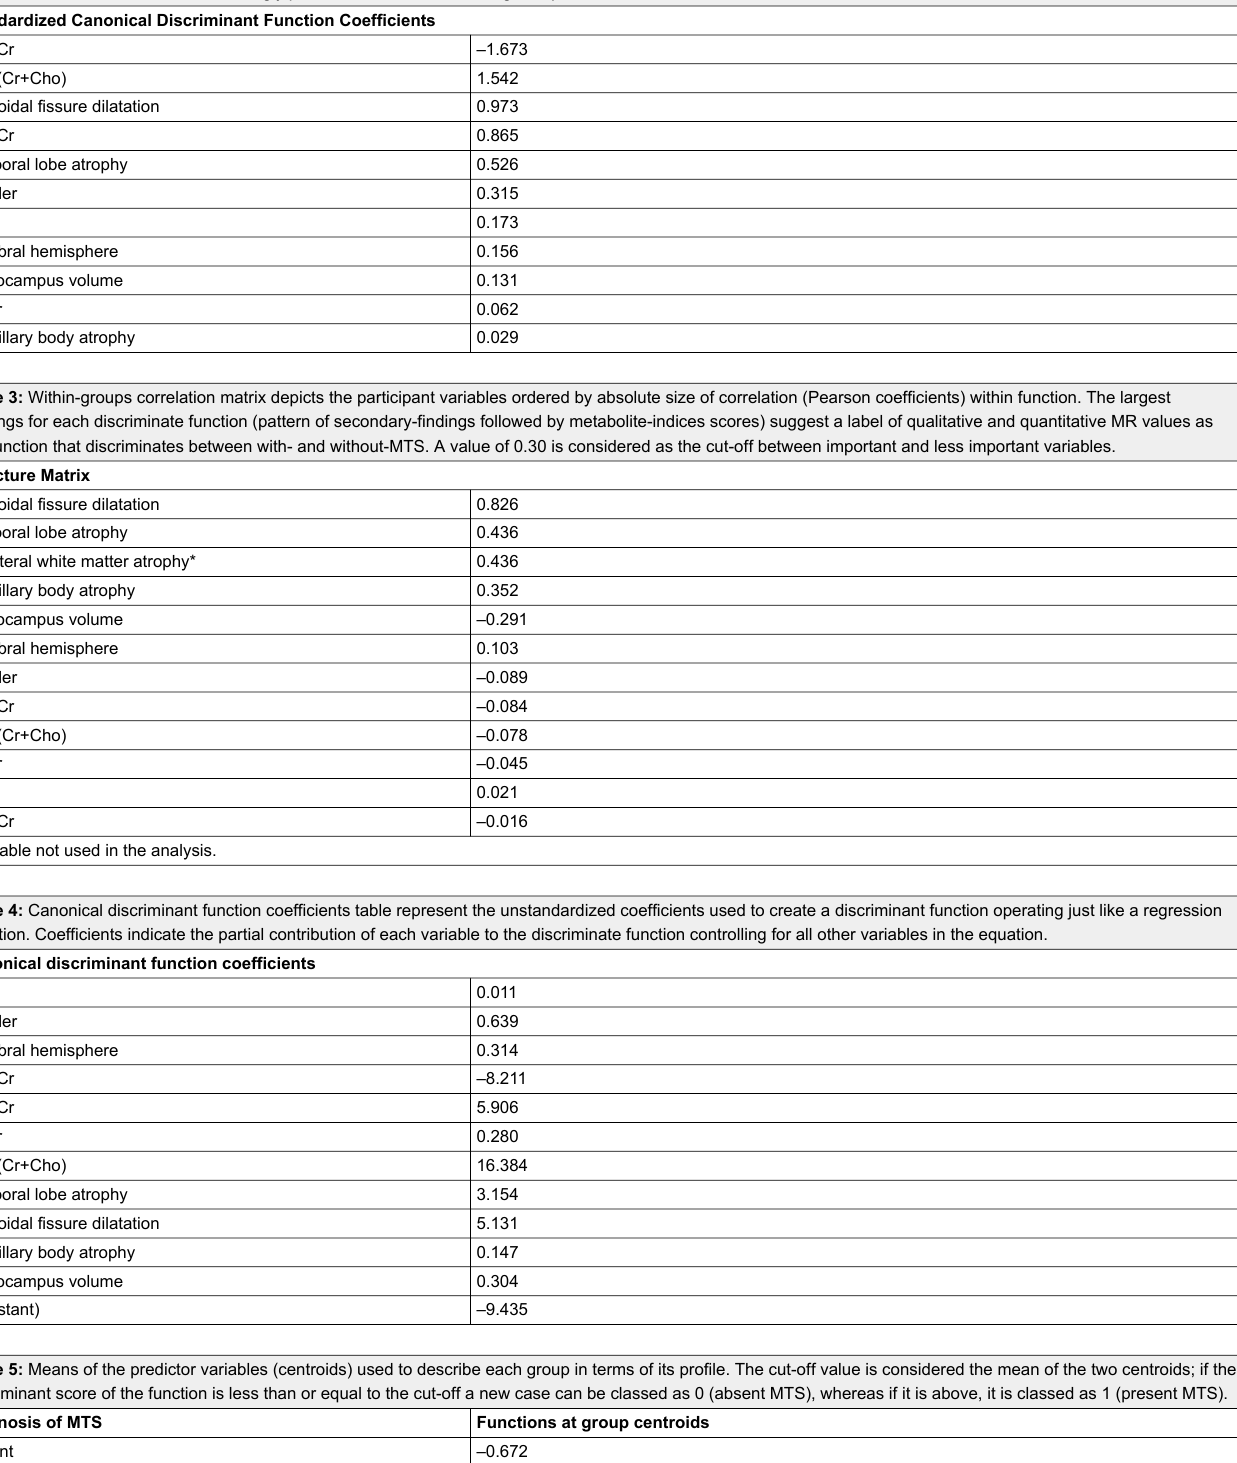
Table 2: Independent variables included in the discriminant analysis ordered by their Standardized Canonical Discriminant Function Coefficients (variables with larger coefficients stand out as those that strongly predict allocation to each diagnosis). Standardized Canonical Discriminant Function Coefficients